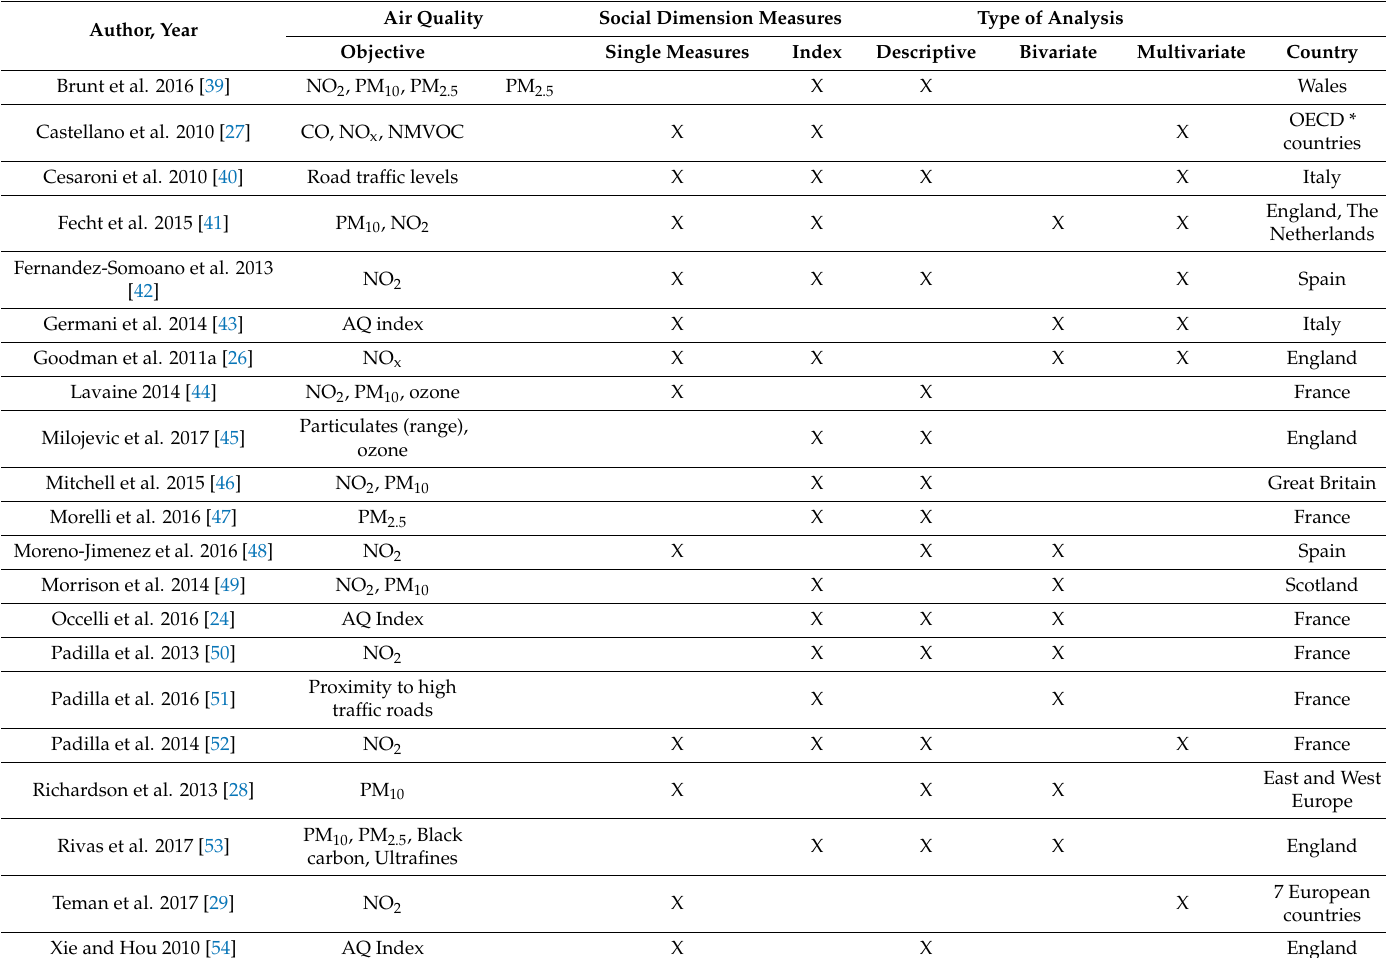
Table 2. Description of 21 ecological studies. NMVOC: non-methane volatile organic